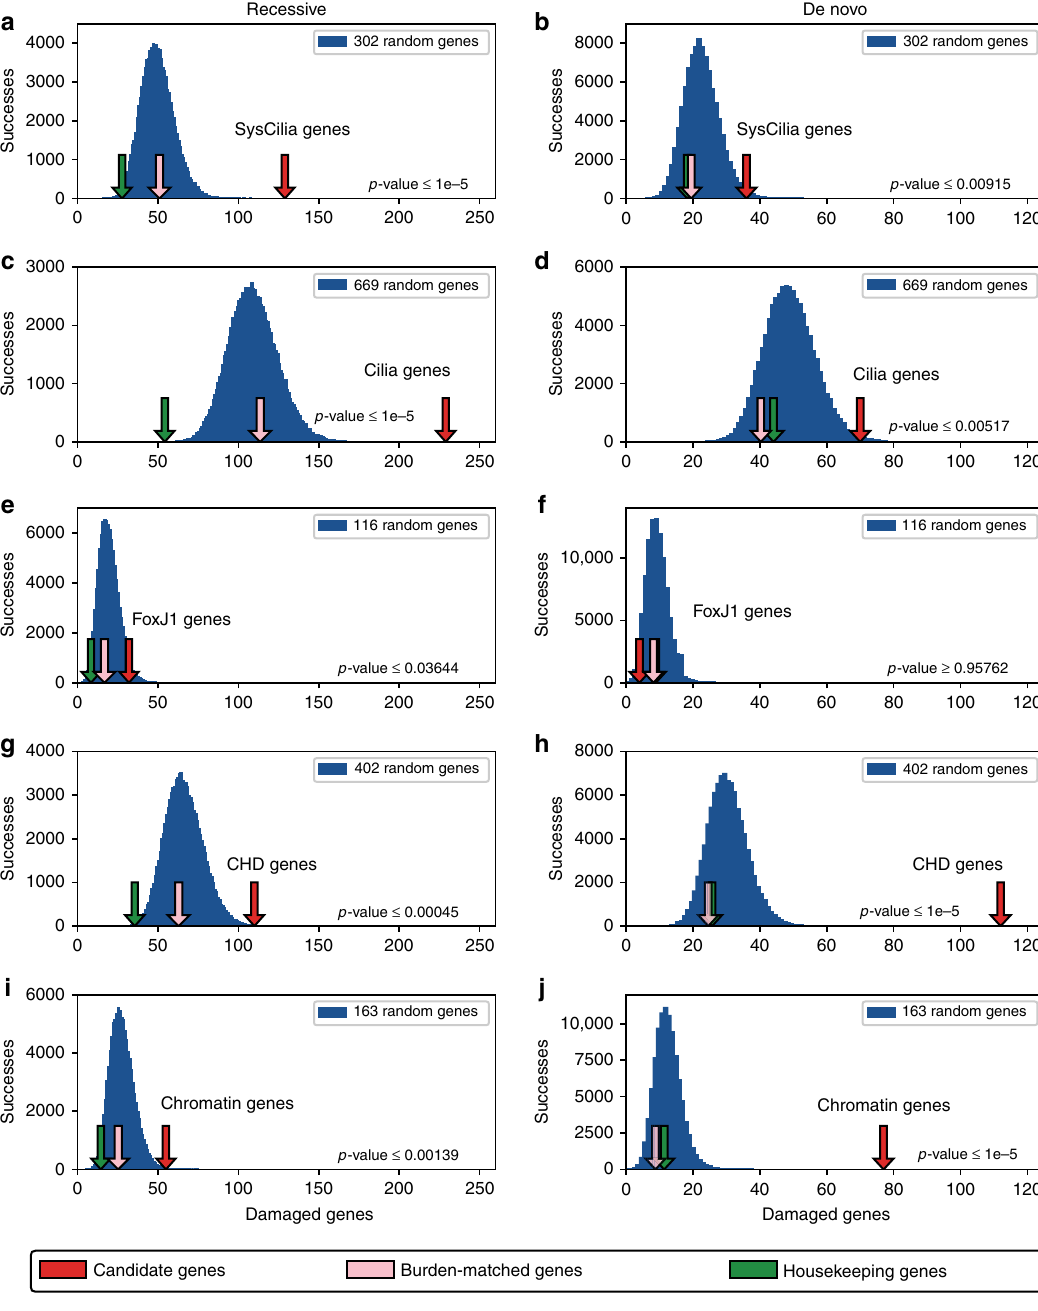
Fig. 3 Enrichment pro fi les for damaged cilia and chromatin genes in CHD probands. Five candidate gene lists, SysCilia (302), Cilia (669), FoxJ1 (116), CHD (402), and chromatin-modifying (163) genes were tested for enrichment in damaging genotypes using 2391 congenital heart disease trios. The number of damaged genes discovered in the 2391 probands for each candidate gene list (red arrows) is compared to the distribution of damaged genes found using random gene lists of equal size (blue distributions, 100,000 independent random gene lists per distribution). a , c SysCilia and Cilia genes are highly enriched for damaged recessively inherited genotypes. b , d SysCilia and Cilia genes show only modest enrichment in de novo mutations. e , f FoxJ1-responsive genes are also modestly enriched for recessive variation but not for de novo variation. g , i CHD and chromatin-modifying genes are only modestly enriched for damaging recessive genotypes. h , j In contrast to cilia genes, known CHD and chromatin-modifying genes are highly enriched for damaging de novo mutations. Burden-matched control genes (pink arrows) are not signi fi cantly enriched for any gene set. Housekeeping genes (green arrows) are depleted for damaging recessive variation and have a typical amount of damaging de novo variation. All p values are obtained by empirical SysCilia genes . For structural cilia genes, VAAST identi fi ed 129 note is that the burden-matched control lists (pink arrows) are located near the mean in every panel, and never differ damaged genes with recessive or compound heterozygous signi fi cantly from it, meaning that differences in burden across inheritance in 126 probands (Supplementary Data 2). These genes the different gene lists cannot explain the signi fi cance of the include several dyneins ( DNAH1, DNAH5, DNAH6, DNAH11, observations (red arrows) discussed in the following paragraphs. DYNC2H1 ), other components necessary for ciliary assembly and